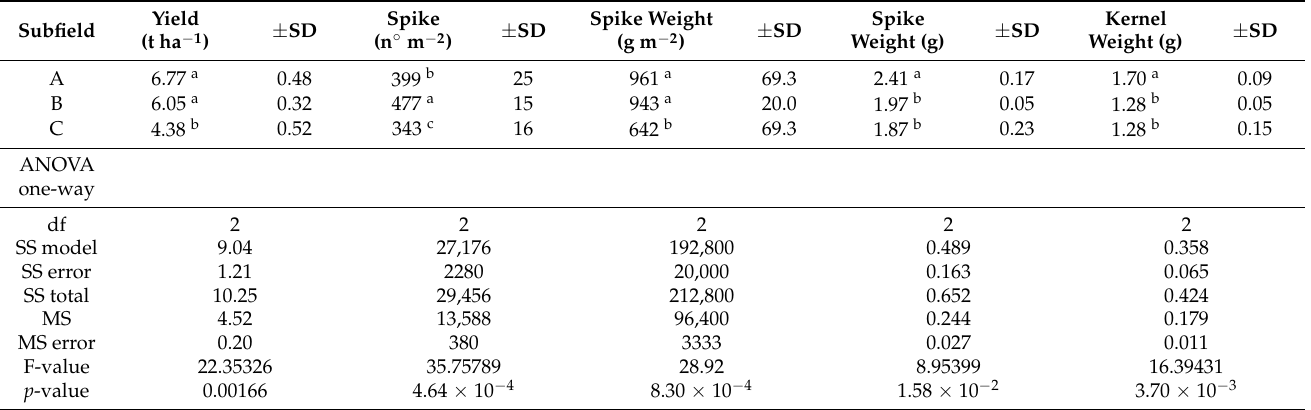
Due to the different locations of the fields in the landscape and topographic features (mor- phology, altitude, exposure), the crop area data for the three areas were analyzed separately. Yield sampling data in area A was 6.77 t ha − 1 , followed by area B with 6.05 t ha − 1 , and finally area C with a mean value of 4.38 t ha − 1 and a significant yield difference related